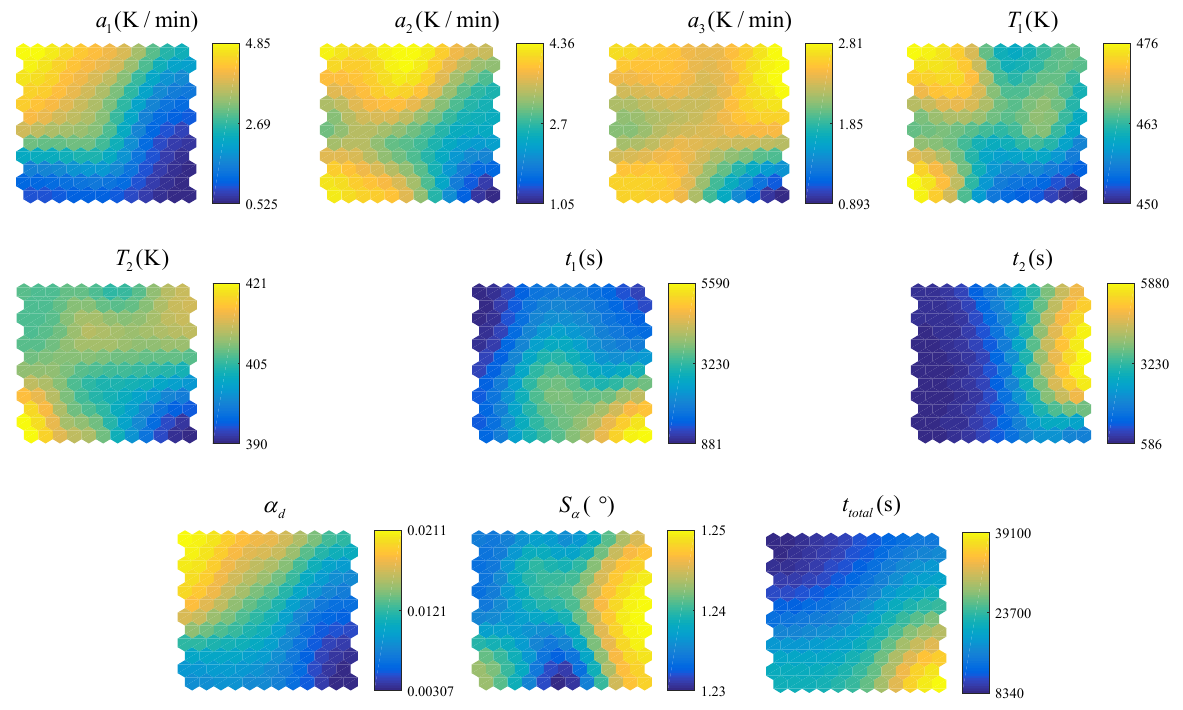
Figure 13. Maximum difference of degree of cure evolution.